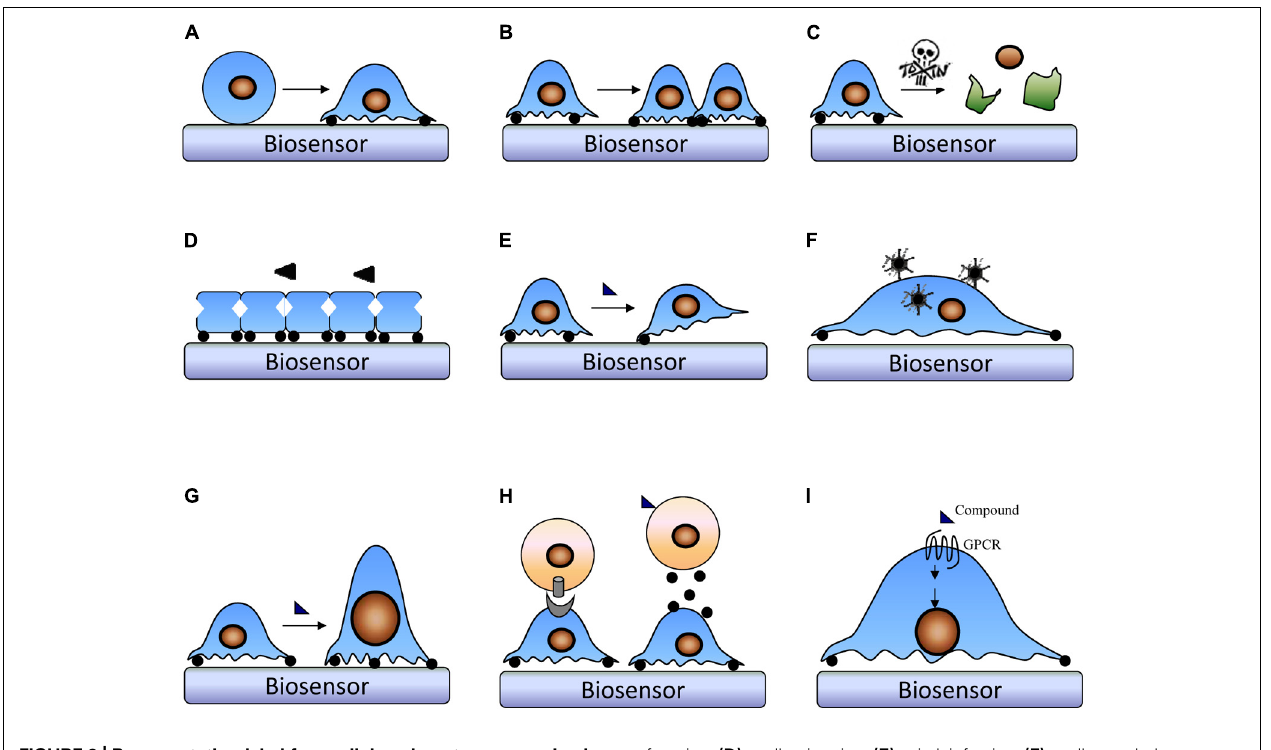
FIGURE 2 | Representative label-free cellular phenotypes examined with label-free techniques. Label-free biosensors can be used to monitor in real-time a great number of cellular process ranging from cell adhesion (A) to cell proliferation (B) , cell death (C) , cell barrier